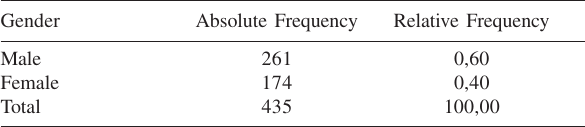
Table 3 - Frequency of patients by gender Gender